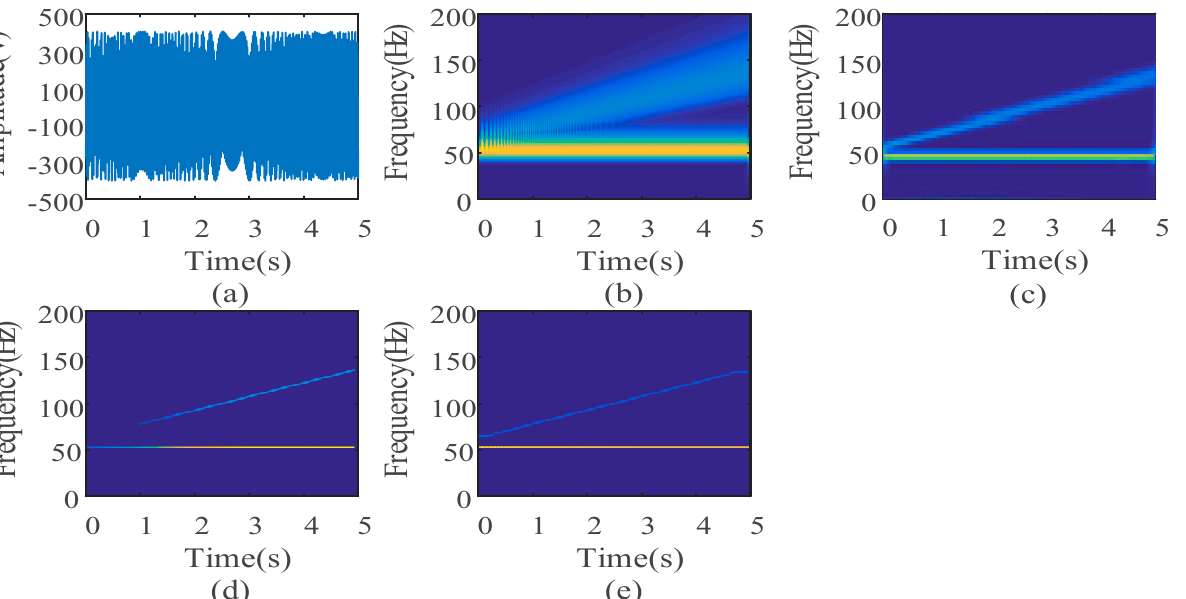
Figure 11. Hardware platform for harmonic signal sampling experiments. The time-varying interharmonic signal was generated by the programmable AC source Chroma 61511, and then the voltage waveform with the time-varying frequency components was output by the interharmonic module of the instrument. The sampling frequency of the MR1200M was set to 2000 Hz, and the sampling time was 5 s. After sampling the signals, the MR1200M transmitted the signal data to the computer in real time via the universal serial bus interface. The collected interharmonic signal was then analyzed by ST, SSTFT, WT and SAST, and the time-frequency spectra that were yielded are drawn (Figure 12).